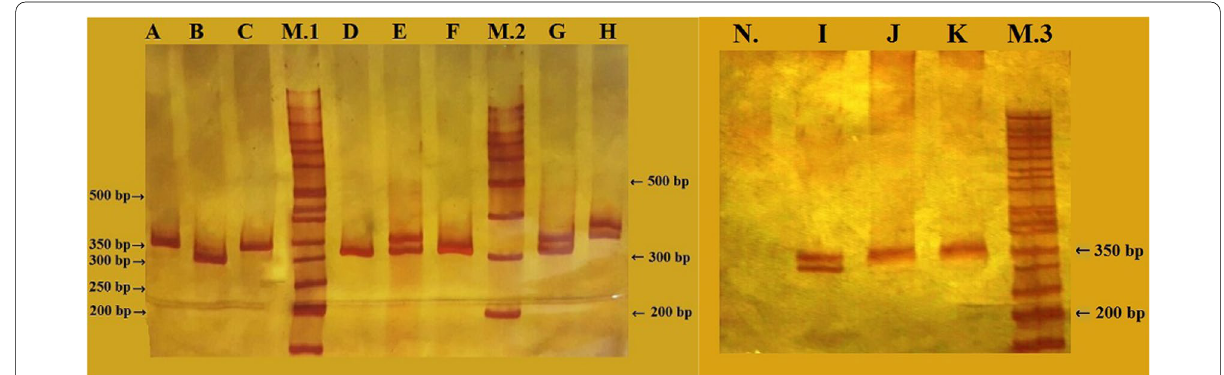
Fig. 1 PCR products containing MAOA-uVNTR polymorphism fragments detected in 8% polyacrylamide gel electrophoresis (PAGE). Column A : 339 bp fragment (as males are hemizygous for this locus), B : 294 bp, C: 339 bp, M.1 : 50 bp DNA Marker, D : 324 bp, E : 339 bp and 354 bp (heterozygote female), F : 324 bp, M.2 : 100 bp DNA Marker, G: 324 bp and 354 bp, H : 354 bp and 384 bp, N. : No DNA (control), I : 324 bp and 339 bp, J : 354 bp, K : 354 bp, M.3 : 50 bp DNA